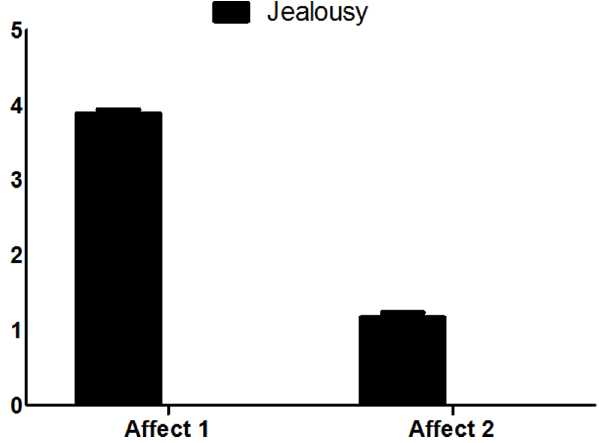
Figure 5. Affect scale. A significant change in negative affect (reduced negative affect) in the schadenfreude